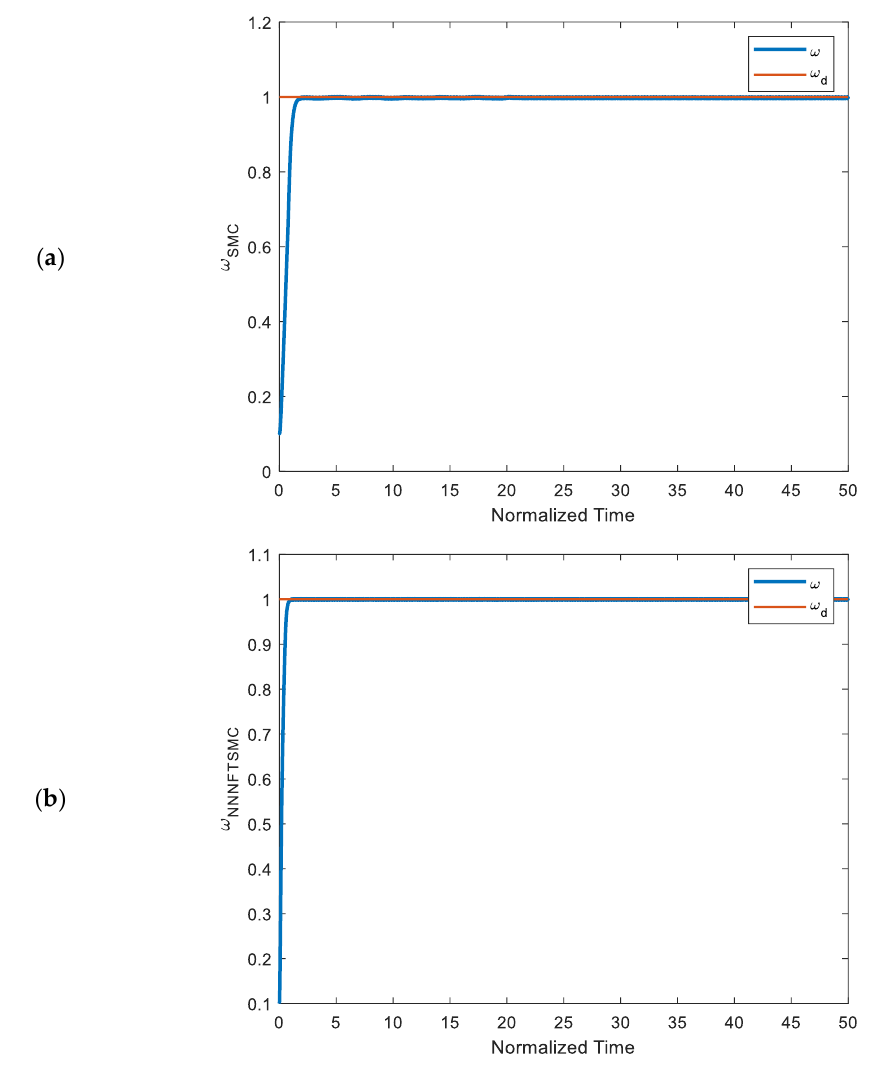
Figure 6. Step response of HTGS using ( a ) SMC and ( b ) proposed controller.